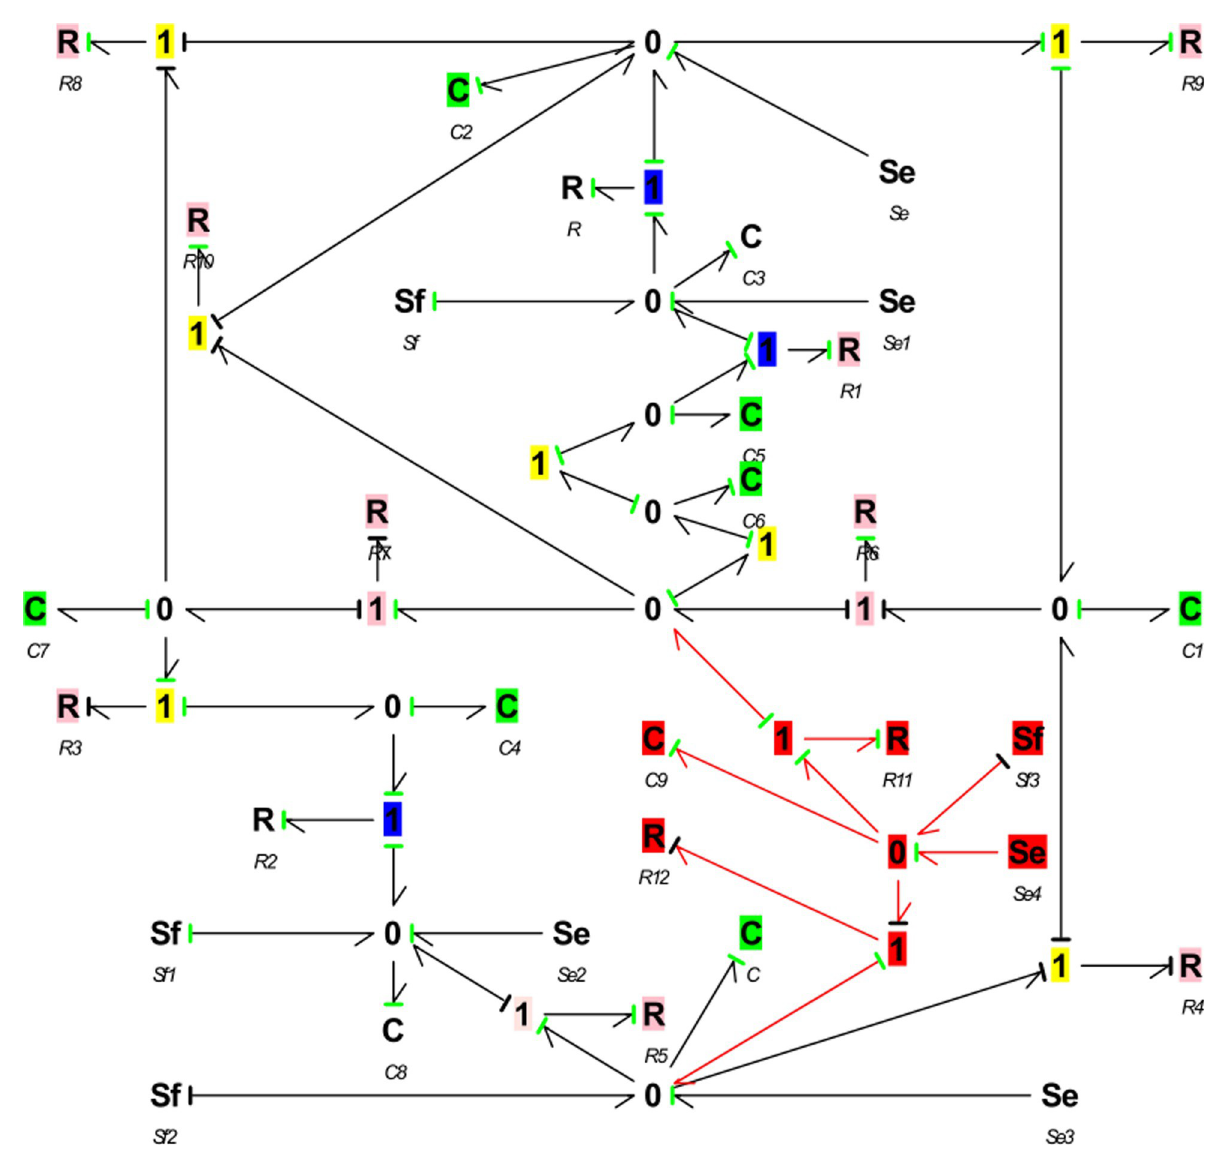
Fig 5. Bond diagram model of